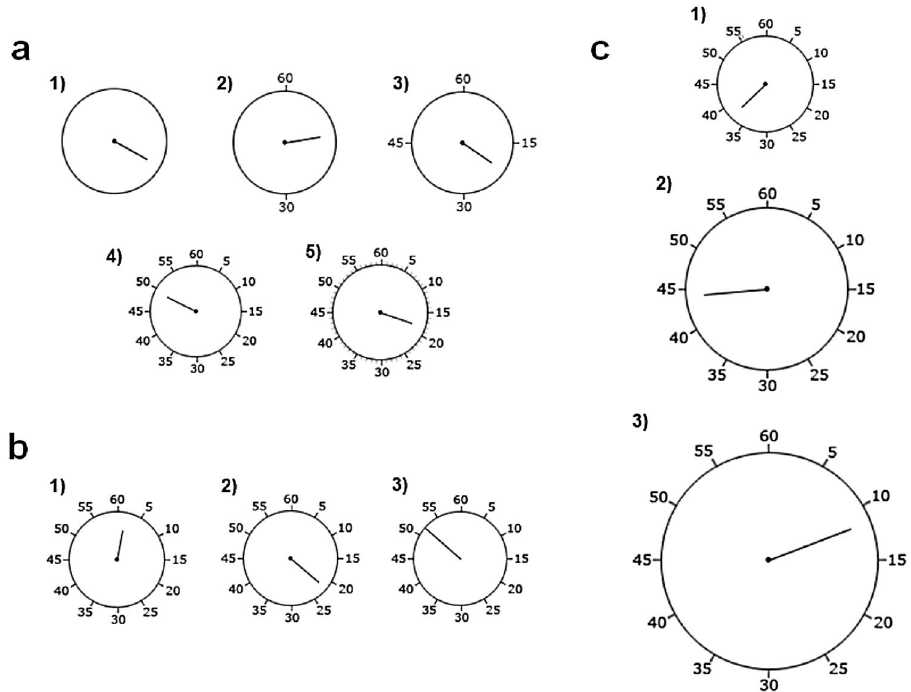
Figure 2. Three of the clock manipulations used across this four-experiment study. Panel a contains all the clock markings manipulations (1–none, 2–30 ′ , 3–15 ′ , 4–5 ′ , 5–5 ′ + 1 ′ ), panel b all the clock hand length manipulations (1–8 mm, 2–10 mm, 3–13 mm) and panel c all the clock radius manipulations (1—small radius, 2—medium radius, 3—large radius).